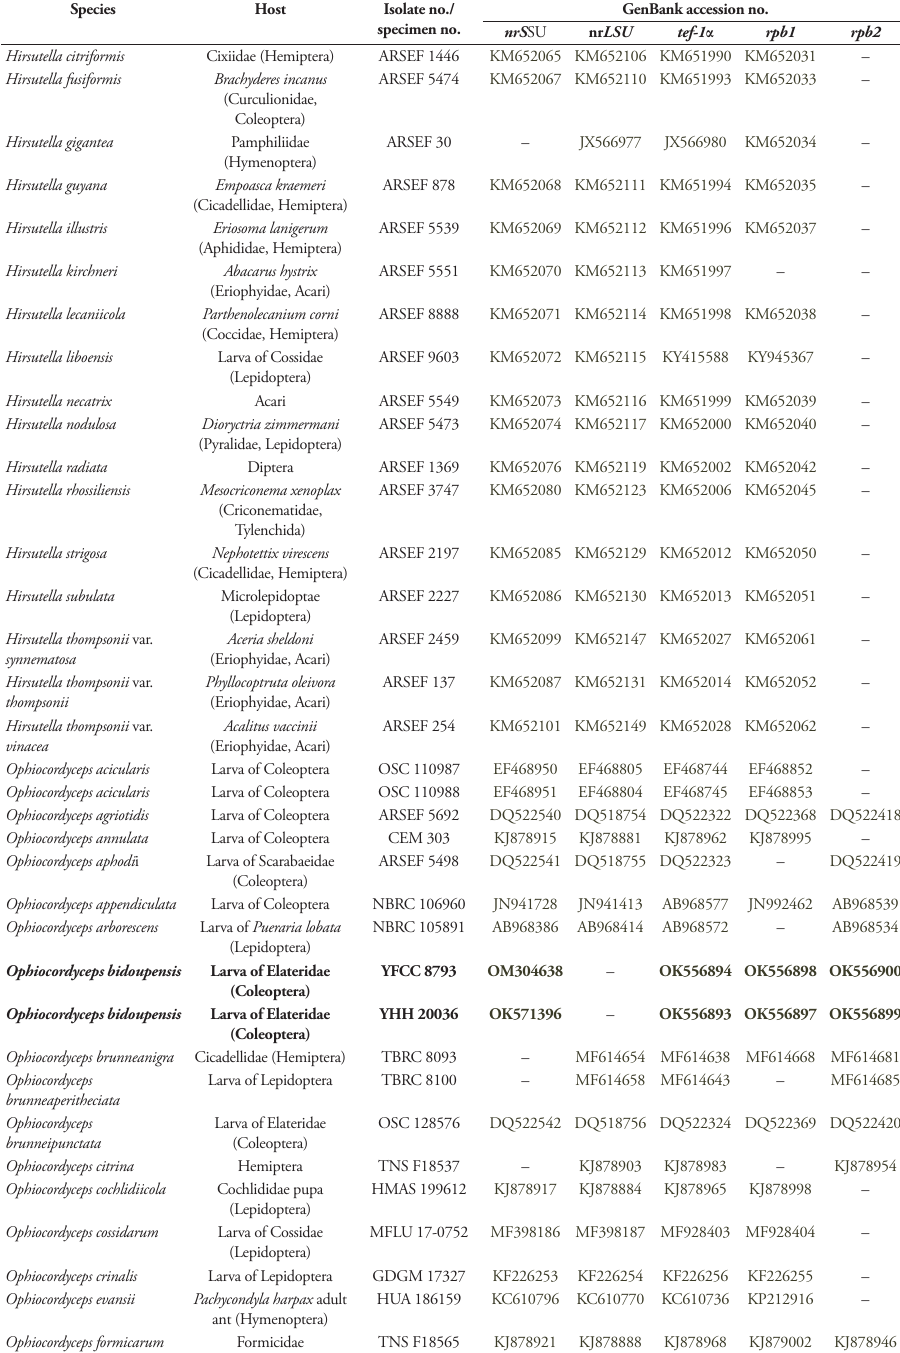
Table 1. Specimen information and GenBank accession numbers of the sequences used in this study.